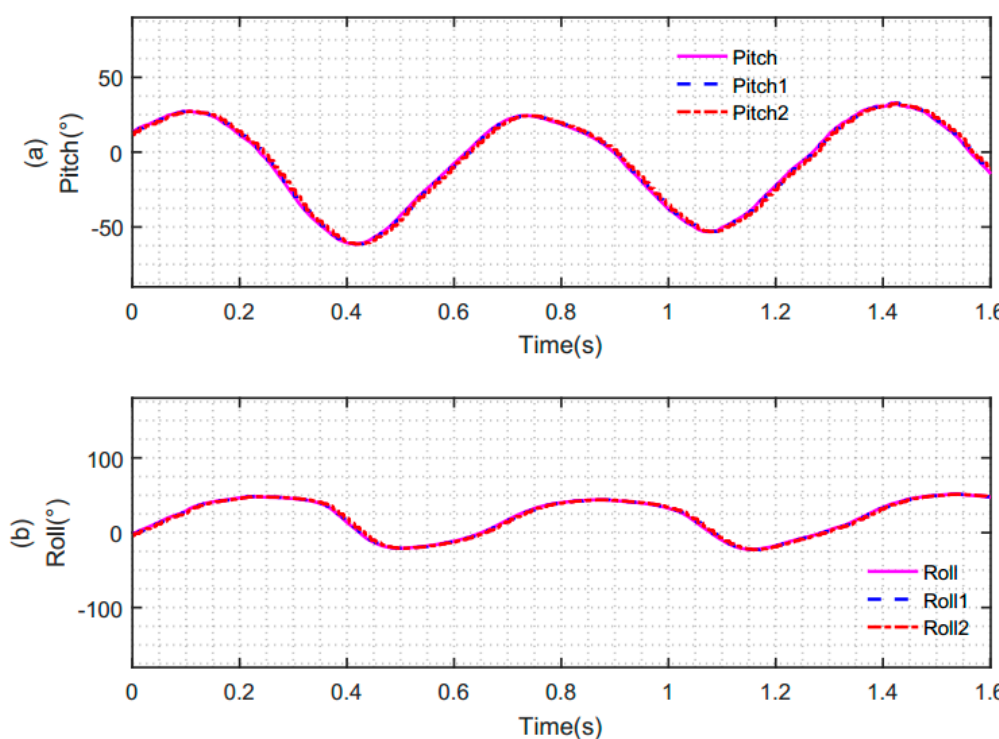
Figure 13. Attitude angle obtained by fusion of the accelerometer and gyroscope data. ( a ) Pitch angle obtained by fusion of the accelerometer and gyroscope under different conditions; ( b ) roll angle obtained by fusion of the accelerometer and gyroscope under different conditions.